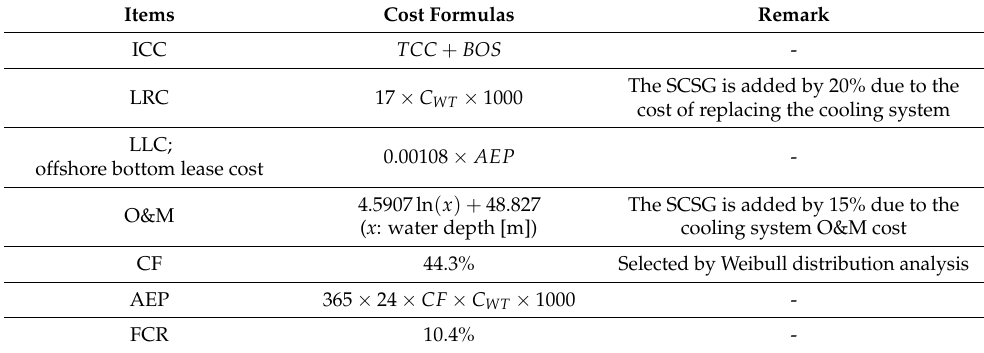
Table 7. Cost formulas for levelized cost of energy (LCOE) calculation of the wind turbine